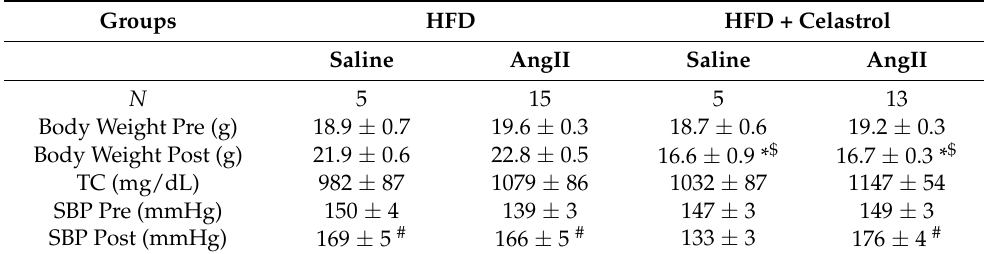
SBP Post (mmHg) 169 ± 5 # 176 ± 4 # Values are represented as means ± SEMs. Body weights and plasma total cholesterol (TC) concentrations were determined at termination. Systolic blood pressure (SBP) was measured prior to (week 0) and during AngII infusion (week 4). * Denotes p < 0.05 Celastrol vs. HFD by two-way ANOVA. $ Denotes p < 0.05 HFD + Celastrol Pre vs. Post. # Denotes p < 0.05 systolic BP post-infusion vs. pre-infusion, by two-way repeated measures